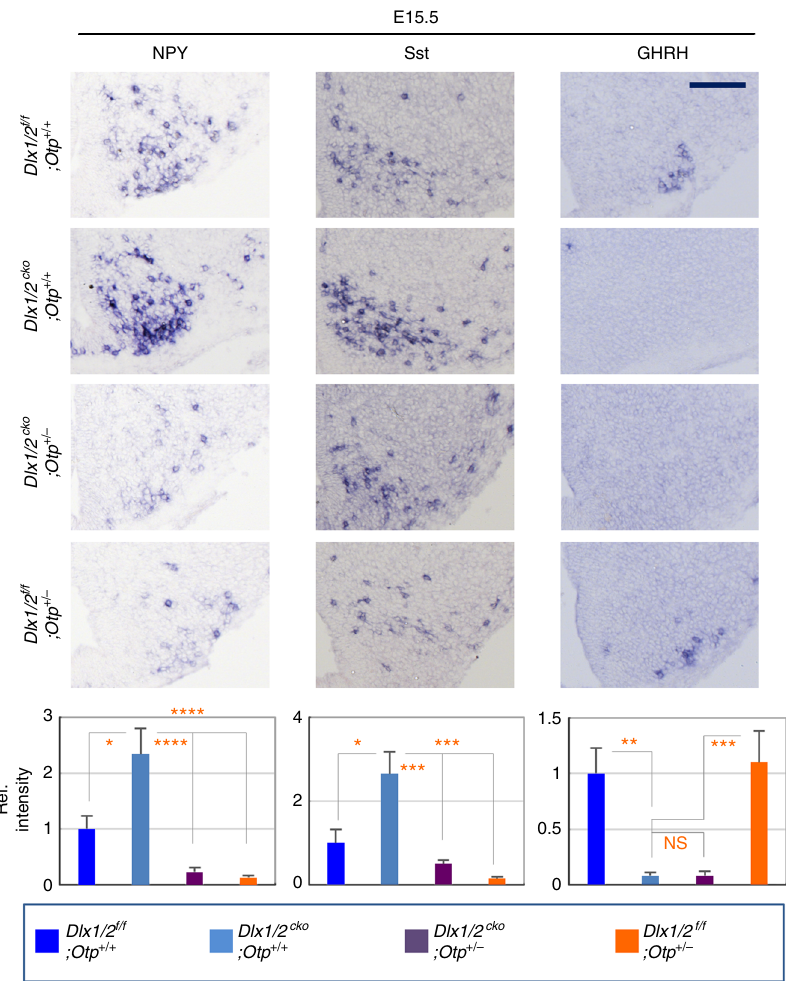
Fig. 6 Dlx1/2 inhibits AgRP-neuronal fate via suppression of Otp. In ISH analyses, the expression of NPY and Sst in E15.5 Dlx1/2 cKO ;Otp + / − embryos ( n = 5) was signi fi cantly lower than that observed with their littermate Dlx1/2 cKO ;Otp + / + embryos ( n = 3) and rather comparable to that observed with Dlx1/2 f/ f ;Otp + / + ( n = 3) and Dlx1/2 f/f ;Otp + / − ( n = 11) embryos. In contrast, the expression of GHRH was comparable between Dlx1/2 cKO ;Otp + / + and Dlx1/2 cKO ; Otp + / − embryos. Quanti fi cation was performed with multiple embryos as indicated and at least three sections from each embryo, and representative images for only one side of the ARC are as shown. Scale bars, 100 μ m. Student ’ s t -test results are as indicated: ∗ p < 0.05, ∗∗ p < 0.01, ∗∗∗ p < 0.001, and ∗∗∗∗ p < 0.0001. Bars represent mean, error bars represent the cages placed on a conventional Metro rack. Data were acquired every second and were averaged into 30min bins for analysis. Chick in ovo electroporation . The P29 ChIPseq peak region and Dlx1 were subcloned into CMV-GFP reporter and RCAS expression vectors, respectively. Chicken eggs were incubated in a humidi fi ed chamber for 48 – 52 h. DNA con- structs were injected into the lumen of chick embryonic spinal cord at HH stage